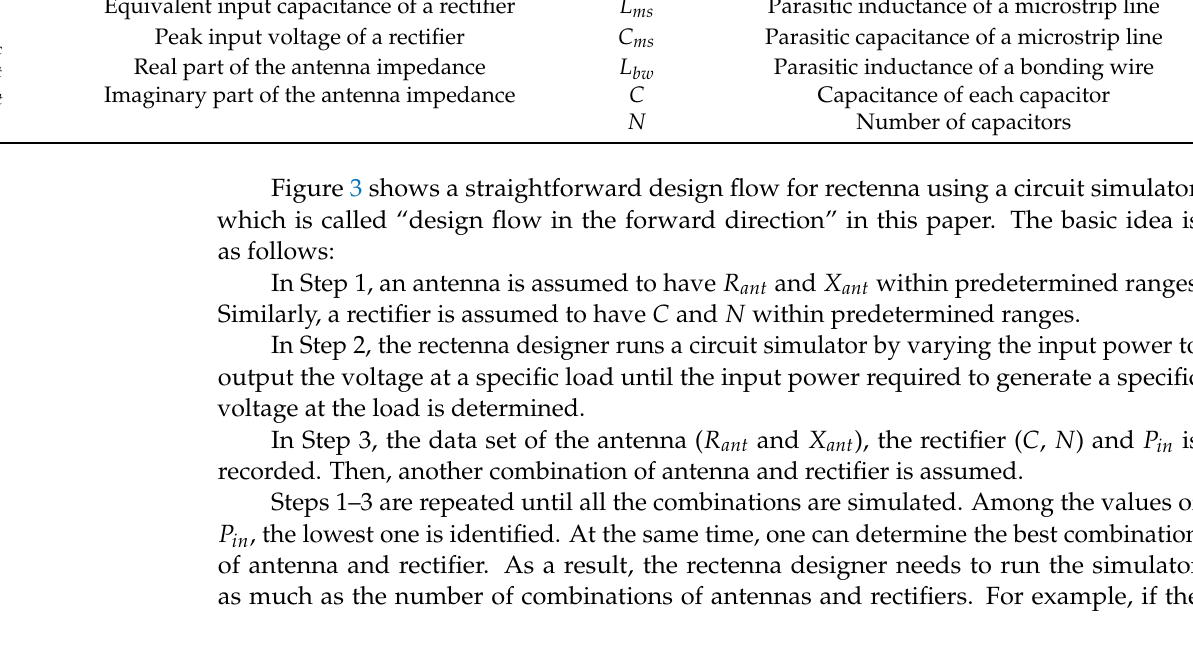
Table 1. Description of